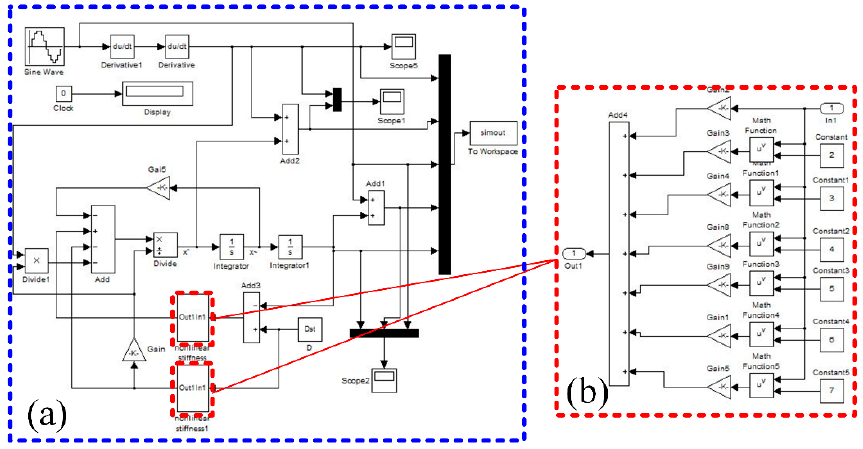
Figure 5. The mathematical simulation program. ( a ) The simulation model under harmonic displacement excitation. ( b ) The simulation model of the nonlinear restoring force.